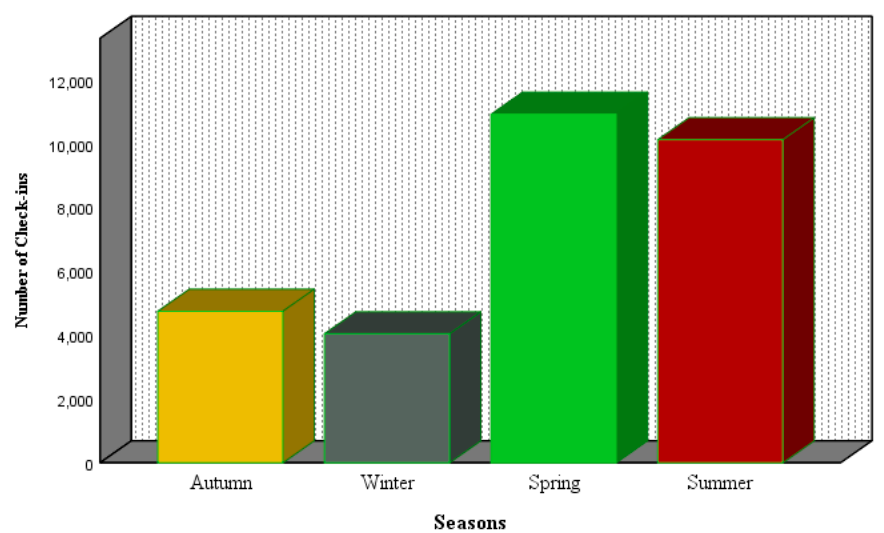
Figure 9. Seasonal variations in the number of park visitors.